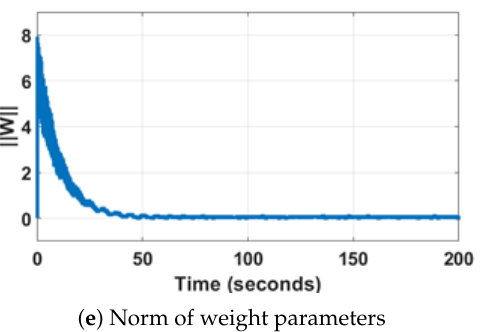
Figure 3. The out responses of the AUV system in the second experiment.